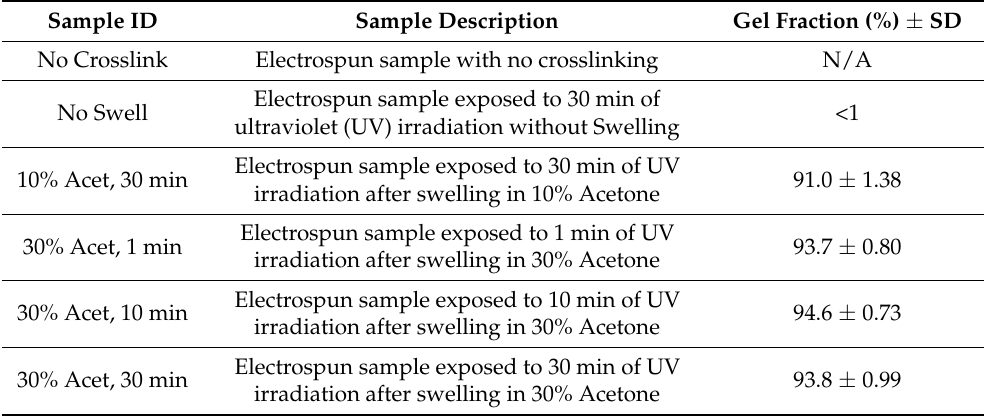
Table 1. Descriptions and sample names used throughout the study along with gel fraction results for each of those samples. n = 3 for gel fraction